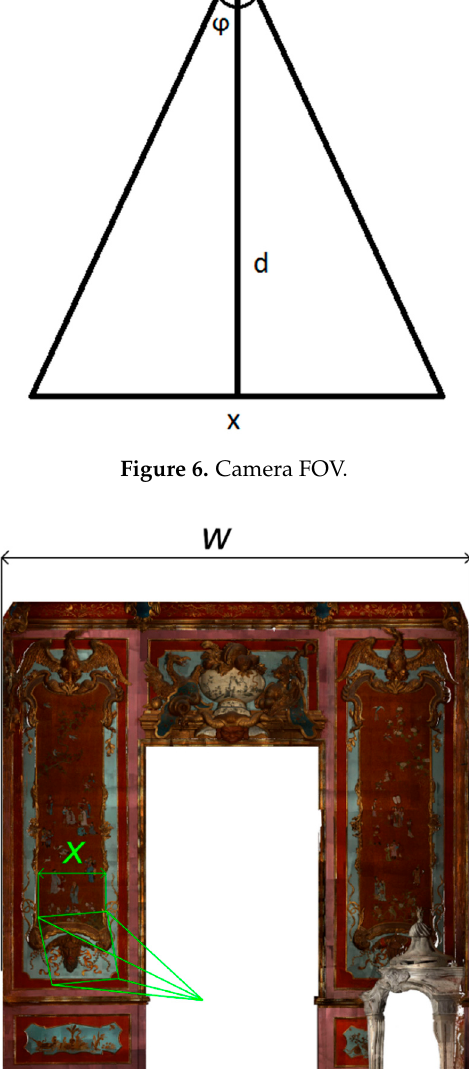
Figure 7. Real-world size of interior w and the size of observed fragment x.